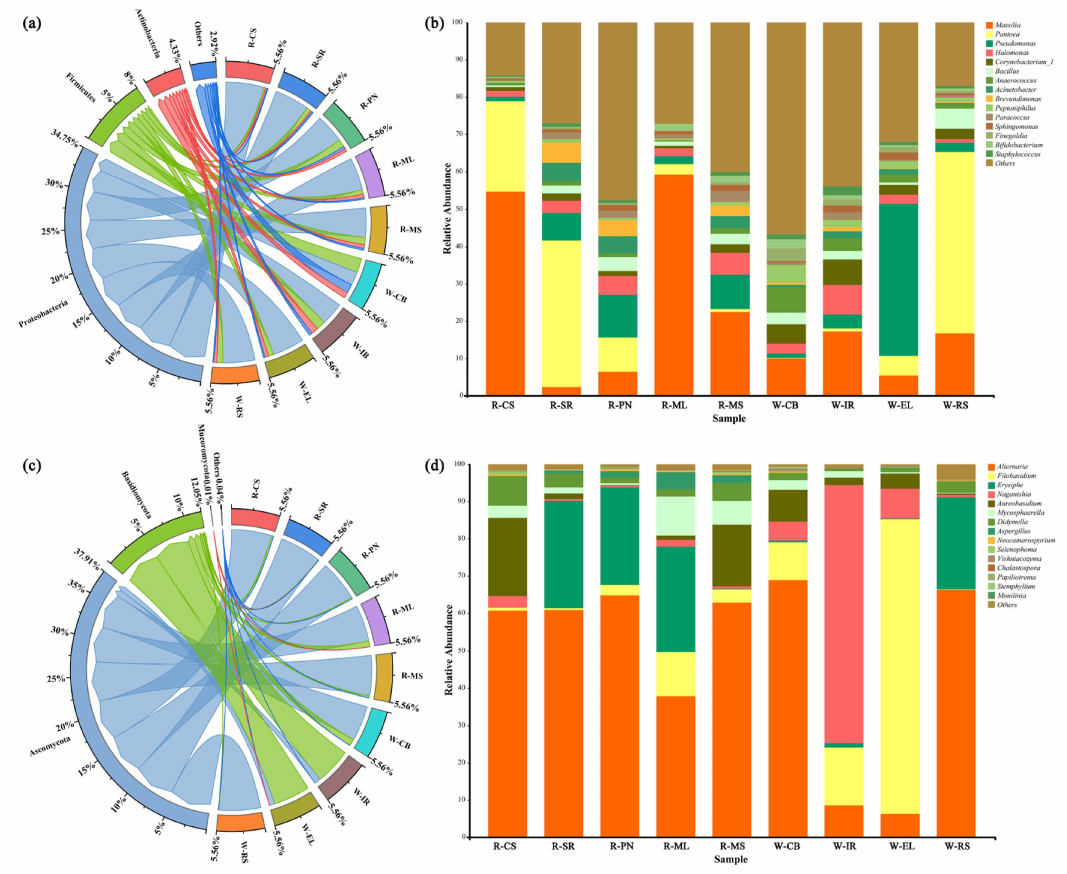
Figure 4. Differences in fungal ( a ) and bacterial ( c ) communities at the phylum level. The relative abundances of the top 15 fungi ( b ) and bacteria ( d ) at the genus